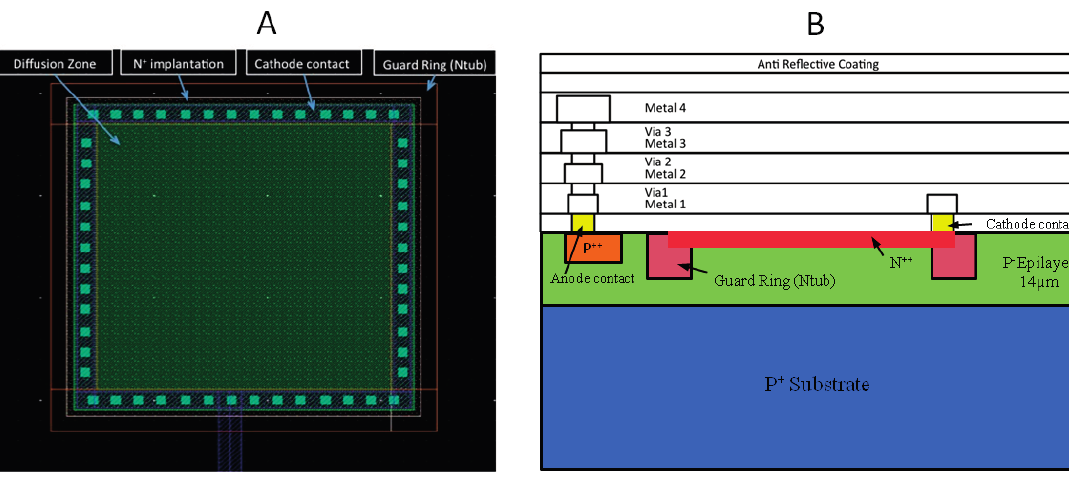
Figure 2. ( A ) Photodiode layout; ( B ) Cross section of the CMOS SPAD.